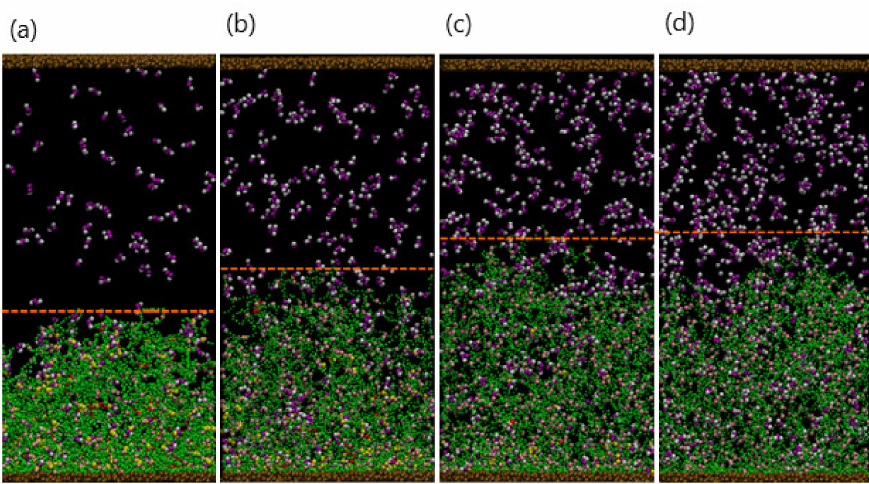
Figure 6. ( a – d ) Snapshots of system at final stage ( t = 5 × 10 6 ) for N EDTA = 300, 500, 700, and 900, respectively. Dashed lines indicate the surface of the gel.